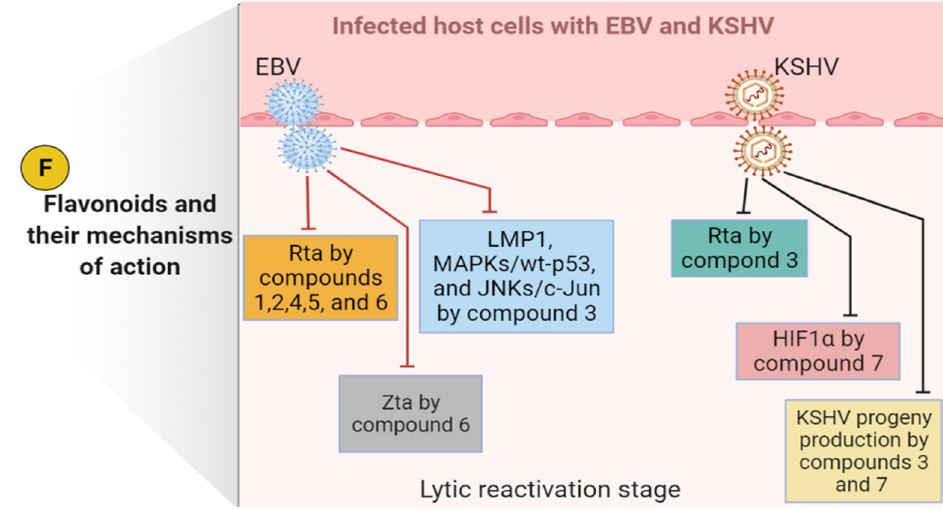
Figure 3. Flavonoids and their mechanisms of action against EBV and KSHV during the lytic reactivation stage of the life cycle. The blunt-end arrows indicate inhibition/downregulation. EBV, Epstein–Barr virus; F, flavonoids (luteolin-7- O - β -D-glucopyranoside ( 1 ), apigenin-7- O -[ β -D-apiofuranosyl (1 → 6)- β -D-glucopyranoside ( 2 ), epigallocatechin-3-gallate (EGCG, 3 ), protoapigenone ( 4 ), protoapigenone 1 ′ - O -isopropyl ether ( 5 ), apigenin ( 6 ), and hesperetin ( 7 )); HIF1 α , hypoxia-inducible factor 1 α ; JNKs/c-Jun, c-Jun NH2-terminal kinases/c-Jun; KSHV, Kaposi sarcoma-associated herpesvirus; LMP1, latent membrane protein 1; MAPKs/wt-p53, mitogen-activated protein kinases/wild-type p53; Rta, replication and transcription activator; Zta, an immediate-early gene.